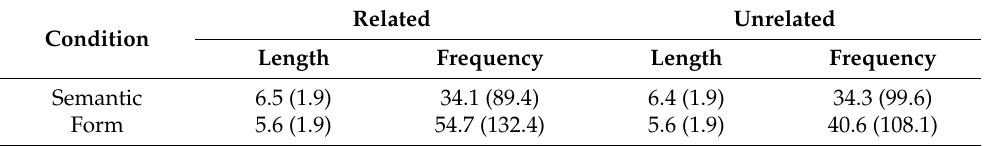
Table 2. Means and standard deviation (in parentheses) for stimuli properties in the critical